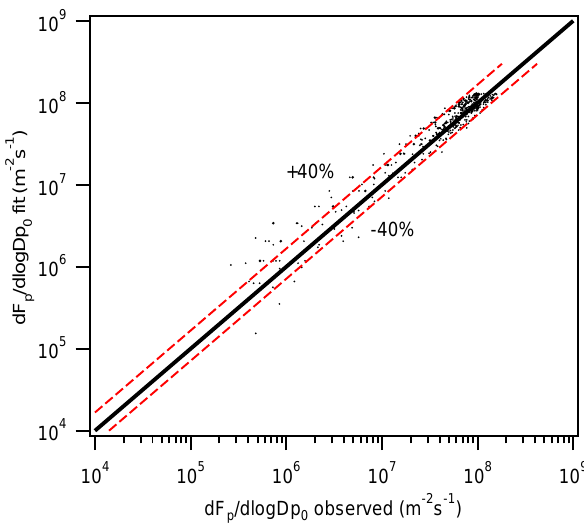
Fig. 14. Comparison of the size-resolved source flux function de- rived in this study at different diatomaceous OC < 0 . 2 µ m concentra- tions and other formulations available in literature ( U 10 =9